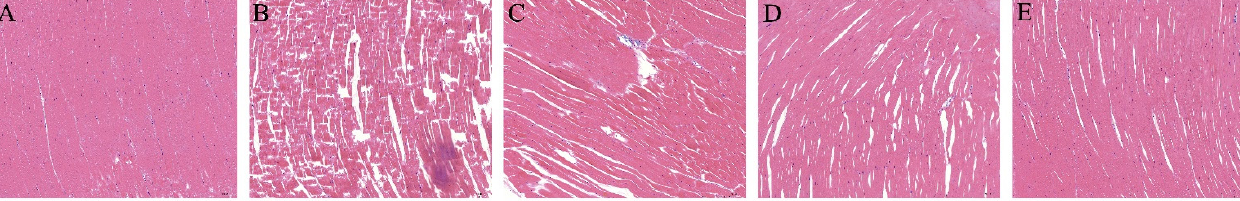
Figure 4. H&E staining images of transverse shrimp muscle tissue from the second abdominal segment treated with fresh water, sodium tripolyphosphate, trehalose, and phosphorylated trehalose after 12 weeks of frozen storage. ( A ): fresh shrimp muscle tissue (0 d); ( B ): shrimp muscle tissue treated with fresh water; ( C ): shrimp muscle tissue treated with sodium tripolyphosphate; ( D ): shrimp muscle tissue treated with trehalose; ( E ): shrimp muscle tissue treated with phosphorylated trehalose.